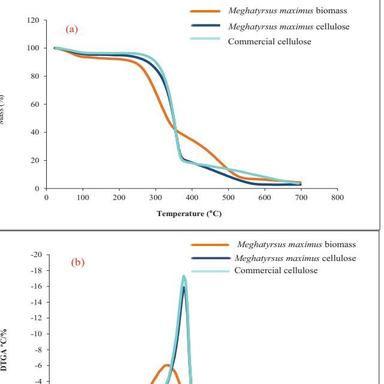
(a) TGA and (b) DTGA curves of MMB, MMC and CC.